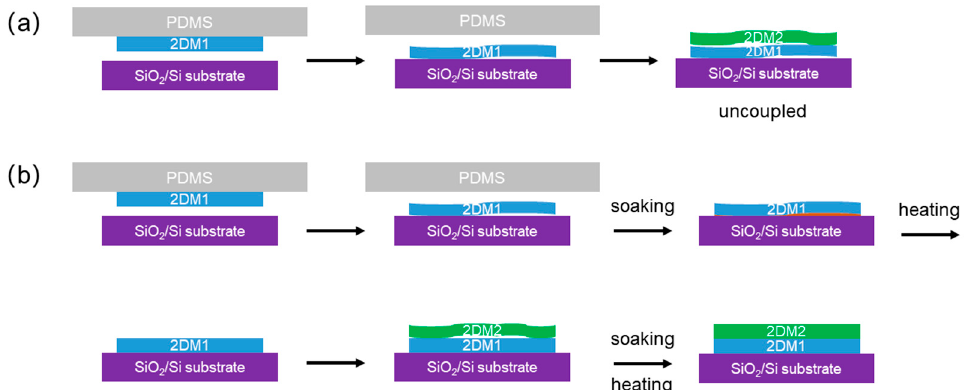
Figure 2. ( a ) Conventional process. ( b ) The ameliorated method involved solution cleaning and hot plate heating. Adapted with permission from [48]. Copyright © 2022 Lei.